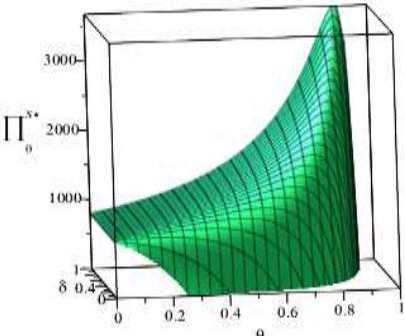
Figure6. E ff ectofmanufacturer’sbehavior θ , δ onbusinessflownetworkunderperformanceconditions. Figure 6. Effect of manufacturer's behavior 𝜃 、 𝛿 on business flow network under performance conditions.